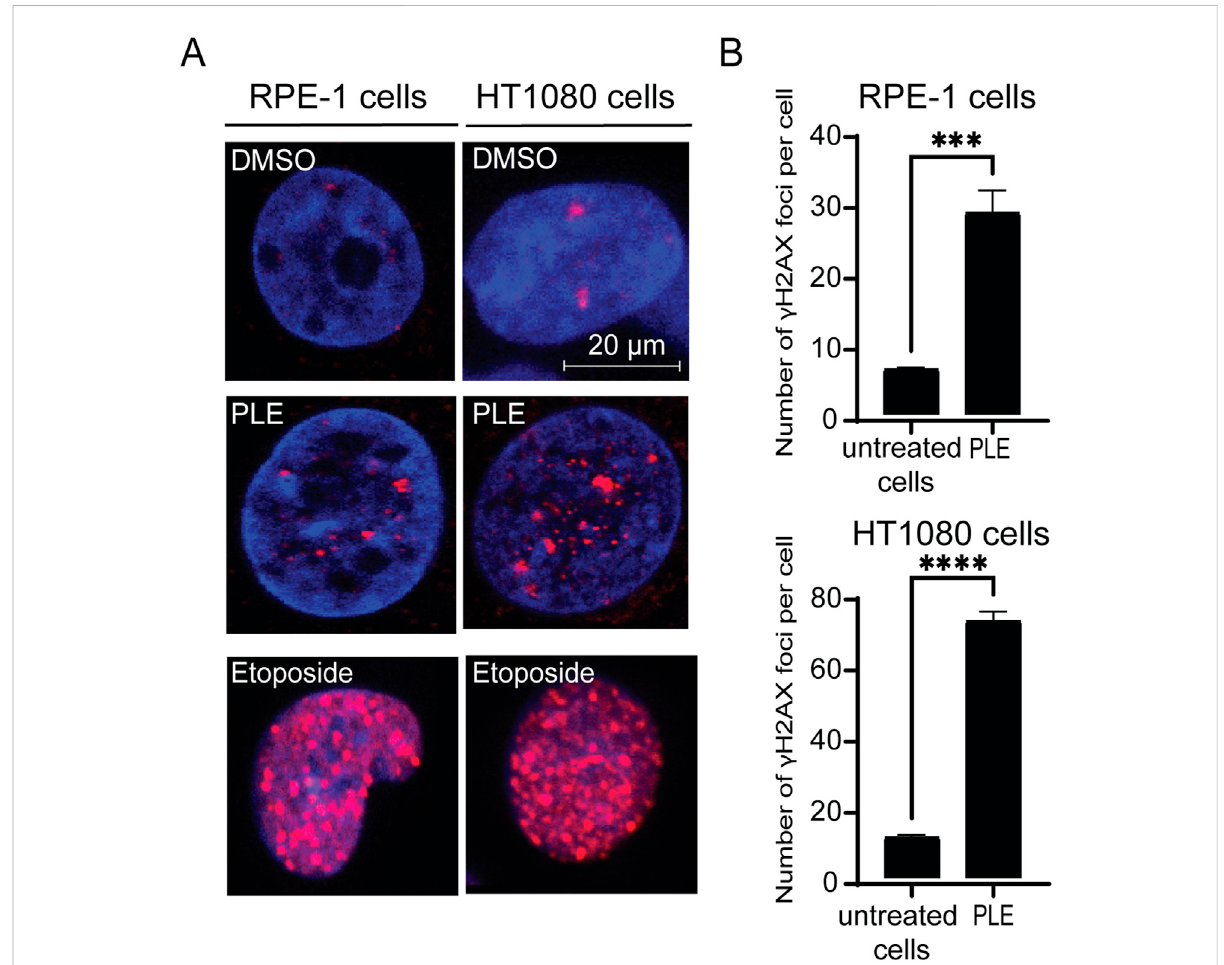
FIGURE 8 Accumulationof γ H2AXfociinHT1080andRPE-1cellstreatedwithPLE. (A) γ H2AXimmunostainingofHT1080cellsbeforeandaftertreatment with PLE. (B) The percentage of γ H2AX foci in HT1080 and RPE-1 cells. As a positive control, we used Etoposide – a drug commonly used for cancer therapy. Etoposide is an inhibitor of topoisomerase II that forms DSBs (Tassanee Lerksuthirat et all., 2020). Error bars correspond to a standard deviation (SD) of four replicates. Statistical analysis was performed using 2way ANNOVA, asterisks indicate statistical signi fi cance (*** p <